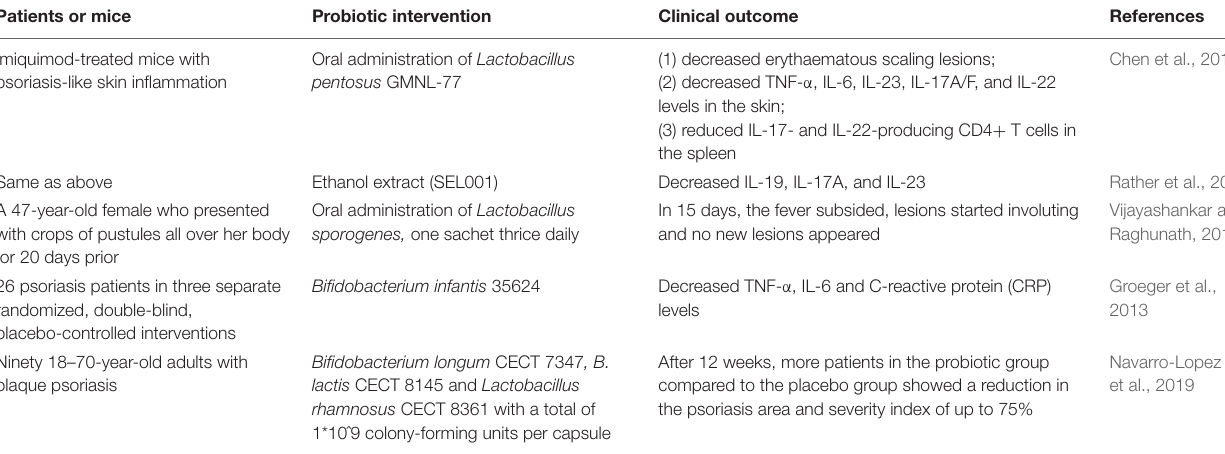
TABLE 3 | Evidence of the beneficial effects of probiotics in psoriasis.